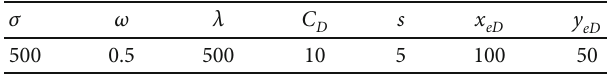
Figure 4: Di ff erent dimensionless bottomhole pressure with di ff erent dimensionless fracture conductivity. Table 1: The basic parameters with sensitivity